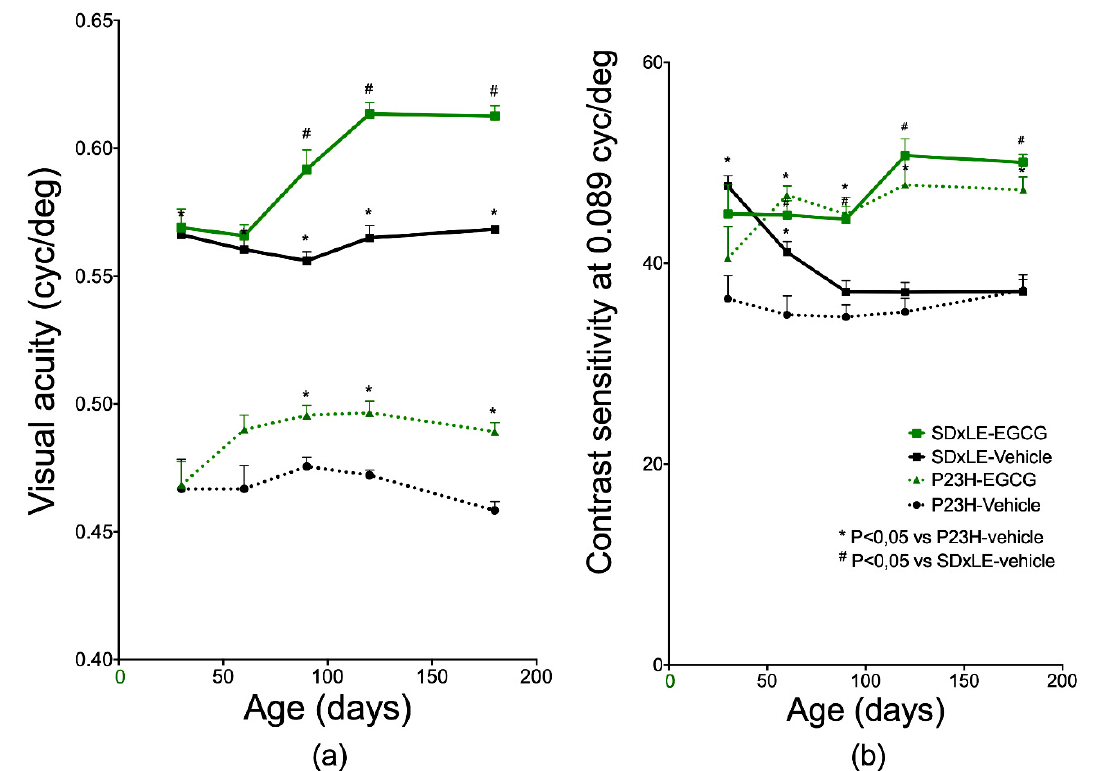
Figure 1. Values of ( a ) visual acuity (VA) and ( b ) contrast sensitivity (CS) at 30, 60, 90 and 180 postnatal days in P23H and Sprague–Dawley (SD) × Long Evans (LE) treatment groups, obtained by the optomotor system on average between the clockwise and anti-clockwise directions. Data represent the mean ± standard error ( n = 5 per group). Mann–Whitney U test, * p < 0.05 versus P23H-vehicle animals, # p < 0.05 versus SD × LE animals.